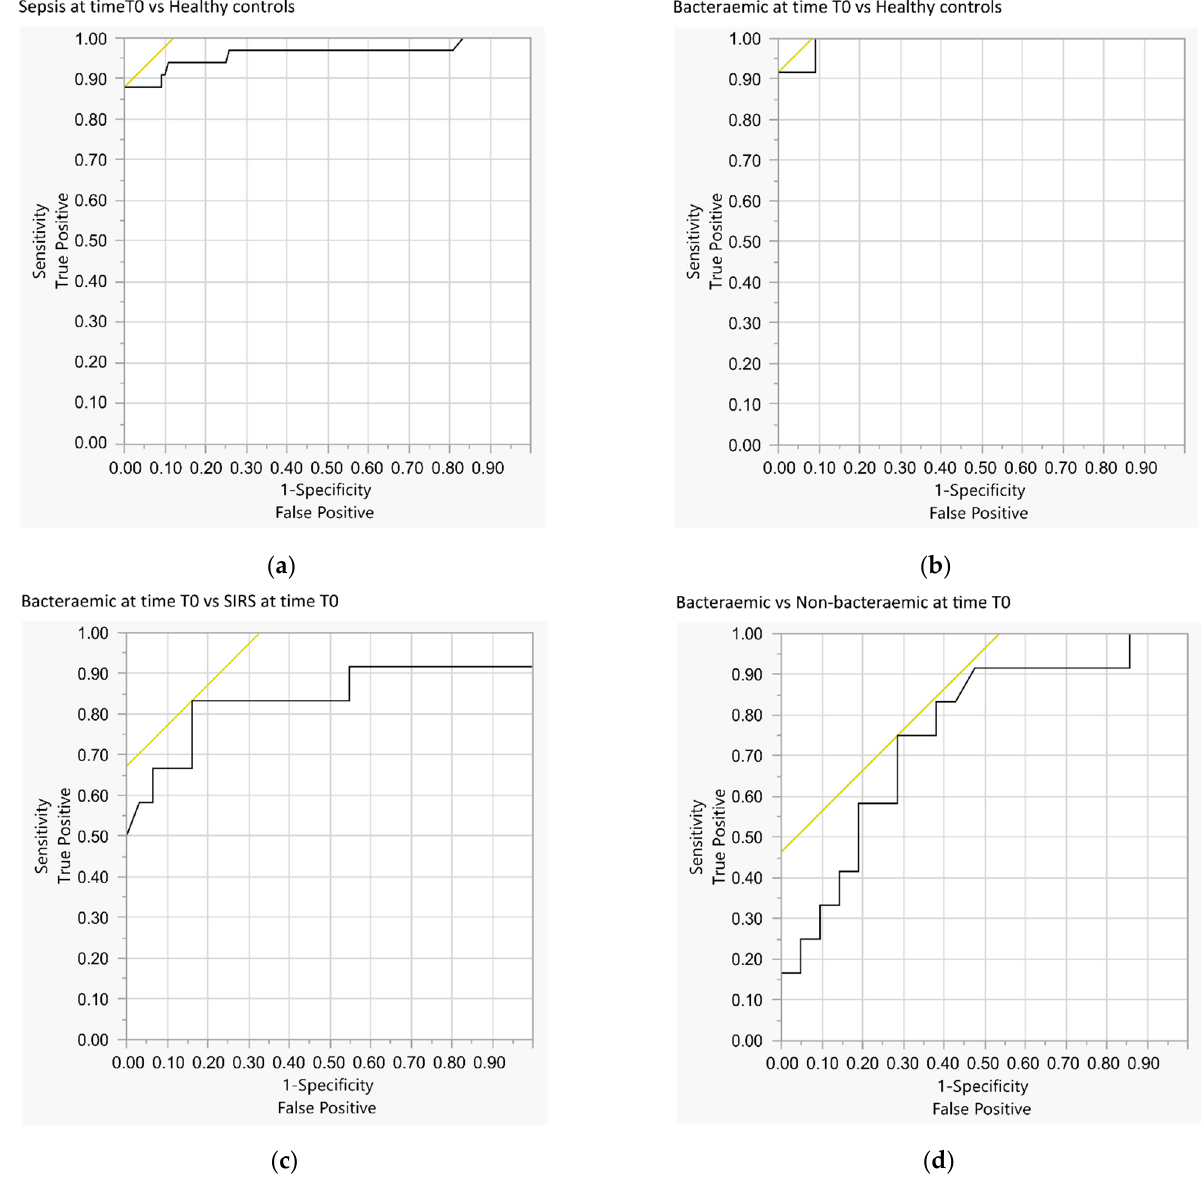
Figure 6. ROC curves for comparisons of selected groups: ( a ) Septic patients on admission vs. healthy controls; ( b ) septic patients with bacteraemia on admission vs. healthy controls; ( c ) septic patients with bacteraemia on admission vs. SIRS patients on admission; and ( d ) septic patients with bacteraemia on admission vs. septic patients without bacteraemia on admission.